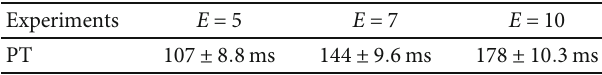
Table 1: The PT in di ff erent experiments.